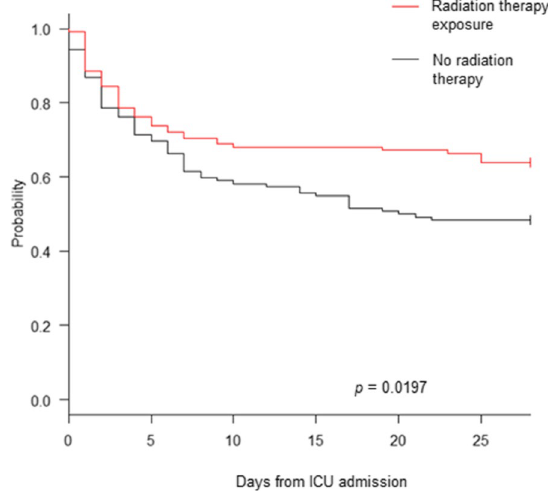
Fig. 1 Probability of survival at day‑28, after matching CO‑32 Benefit‑to‑risk balance of bronchoalveolar lavage in the critically ill. A prospective, multicenter cohort